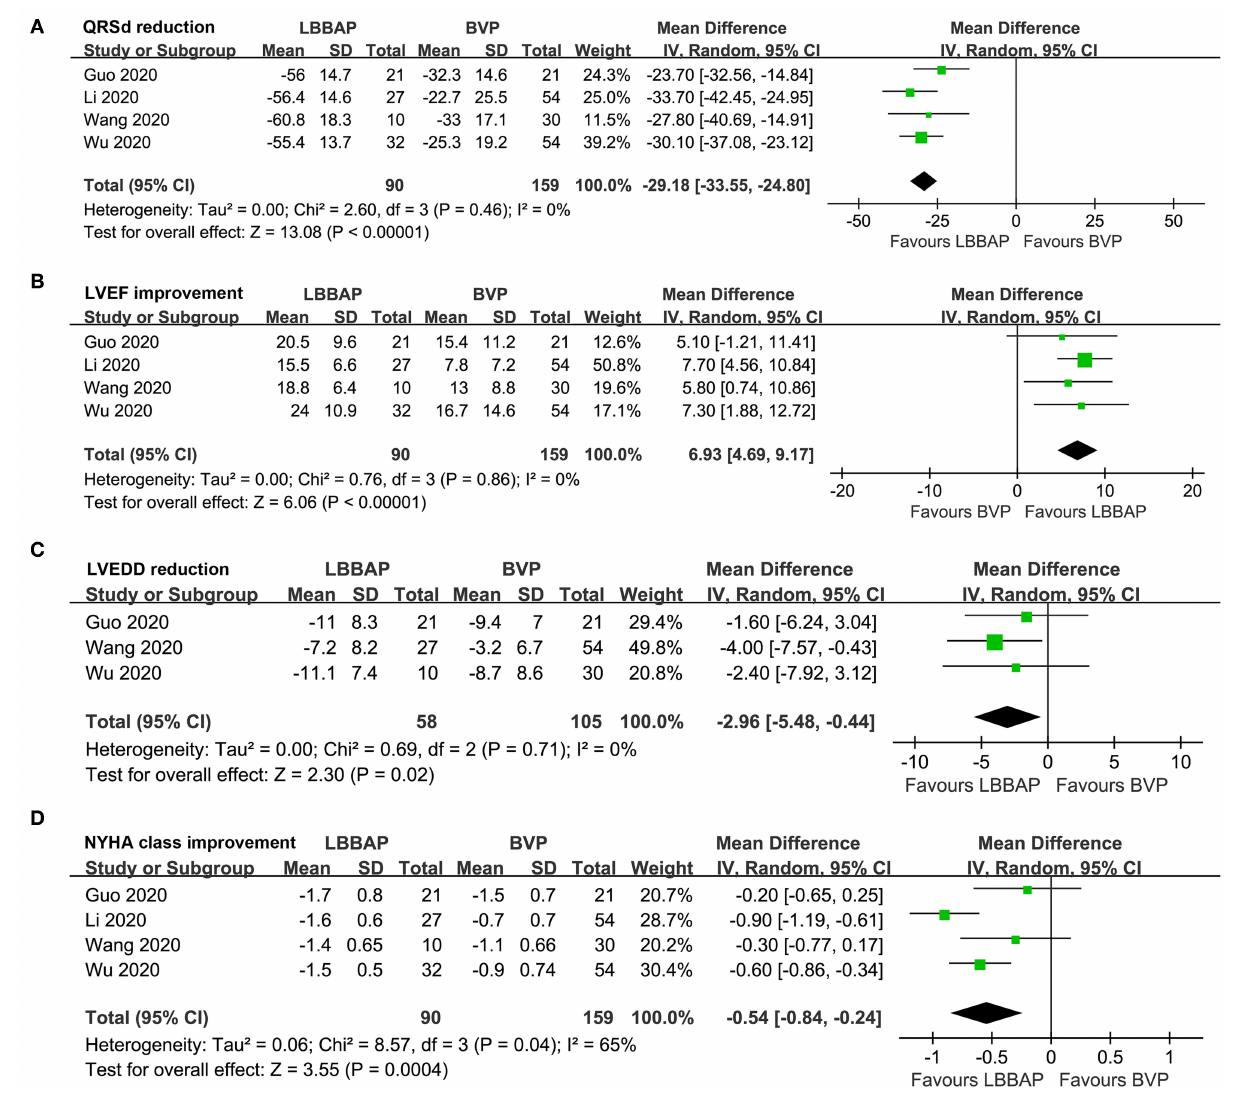
FIGURE 2 | Forest plots for the meta-analysis comparing influences of LBBAP and BVP on QRSd, cardiac function, and clinical symptoms in HF patients with indication for CRT. (A) QRSd, (B) LVEF, (C) LVEDD, and (D) NYHA